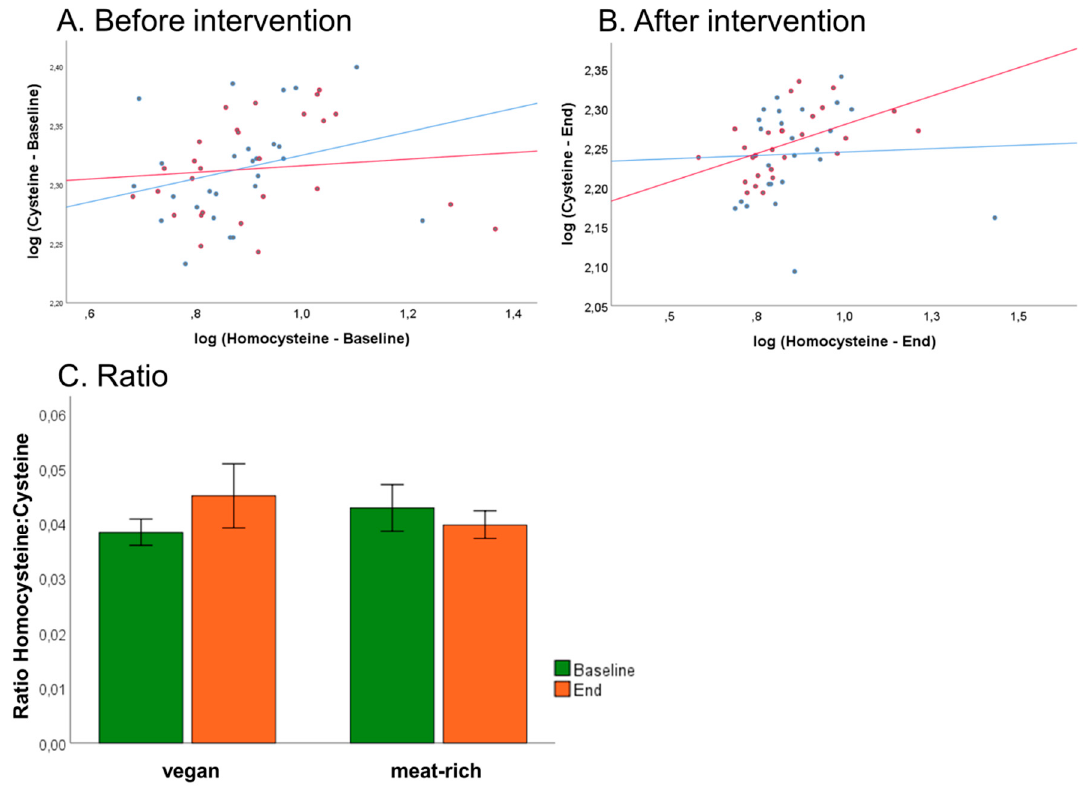
Figure 7. Associations of total cysteine and total homocysteine and influence of diet on B-vitamin status of VD (blue) and MD (red). (Panel A ) Correlation of log of total cysteine and log of total homocysteine before trial. (Panel B ) Correlation of log of total cysteine and log of total homocysteine after trial. (Panel C ) Assessment of B-vitamin status using the tHcy:tCys ratio proposed by Ulvik et al. [17] at baseline and after 4-week intervention, sorted by assigned diet. Ratio shows non-significantly decrease in vegan group and non-significantly increase in meat-rich group, sorted by time (green baseline, orange end); error bars show ± 1 standard error.